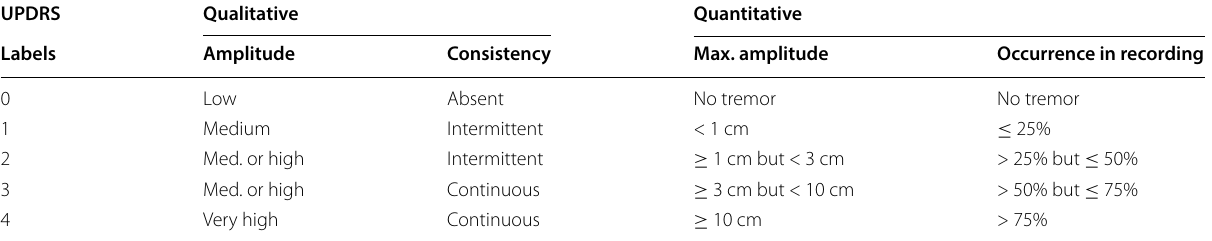
Table 3 UPDRS label based on the rest tremor characteristics (qualitative and quantitative) UPDRS Qualitative